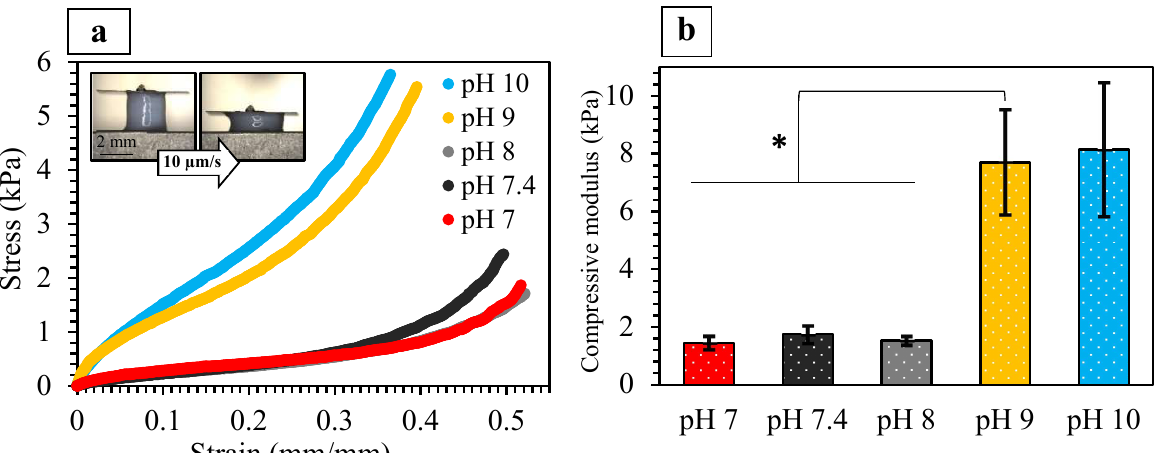
Figure 4. Mechanical properties of GAE-densified collagen gels: ( a ) Micro-compression stress-strain curves, and ( b ) compressive modulus of GAE-densified collagen gels of various pH (* p < 0.05; n = 7). Specimens were positioned such that their aspiration direction was parallel to the direction of the applied